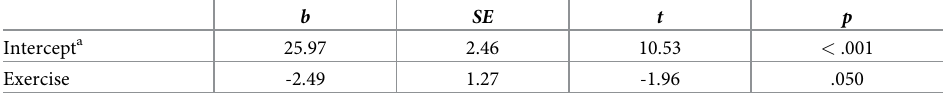
Table 7. Exercise as a predictor of the percentage of meals within the day self-rated as big/somewhat big (Study 2). b SE t p Intercept a 25.97 < .001 Exercise -2.49 1.27 -1.96